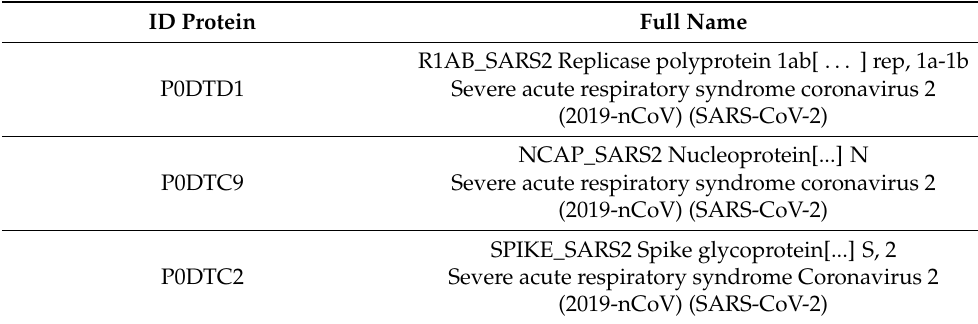
Table 2. Uni-Prot 3 proteins of SARS-CoV-2, checked in proteomic analysis, using ‘SANIST-Hb’ software